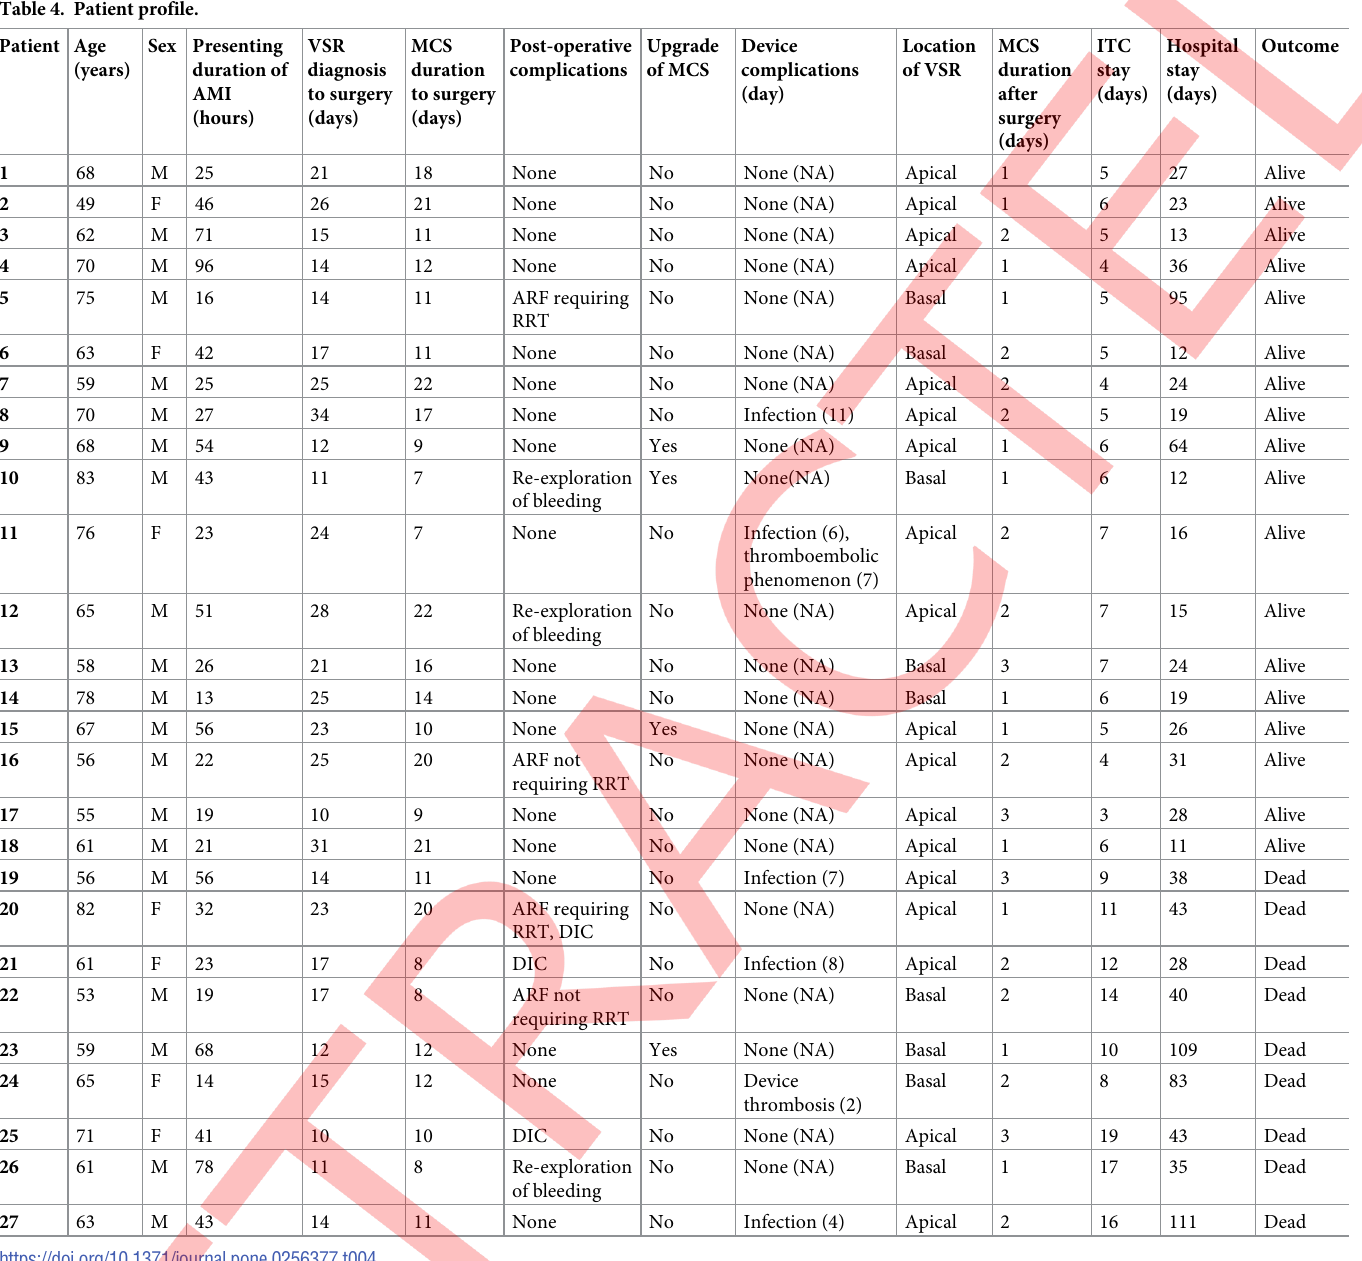
Table 4. Patient